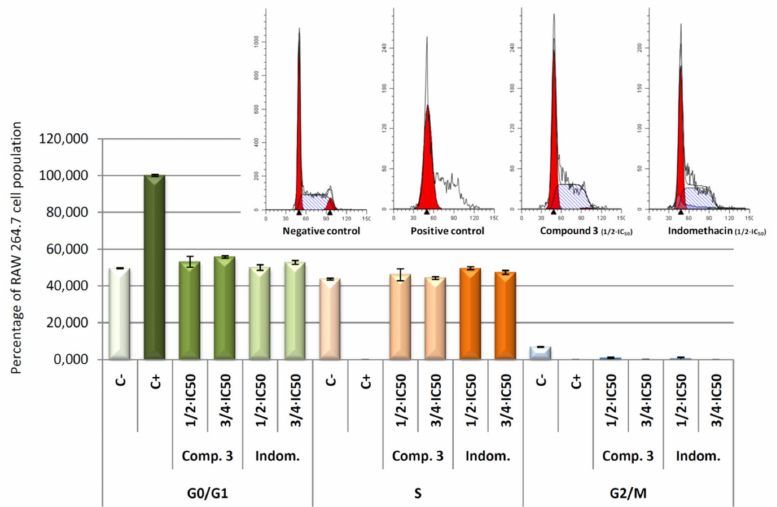
Figure 10. Percentage of RAW 264.7 macrophage murine cells in the di ff erent phases of cellular cycle, G0 / G1, S and G2 / M. Cells were treated with LPS for 24 h, to induced inflammatory process, after that cells were treated with compound 1 , 2 , 3 , and 4 for 24 h at its 1 / 2 × IC 50 and 3 / 4 × IC 50 concentrations. In addition, results obtained for negative control (untreated cells) and positive control (cells only treated with LPS) are showed. Data represent the mean ± S.D. of at least two independent experiments performed in